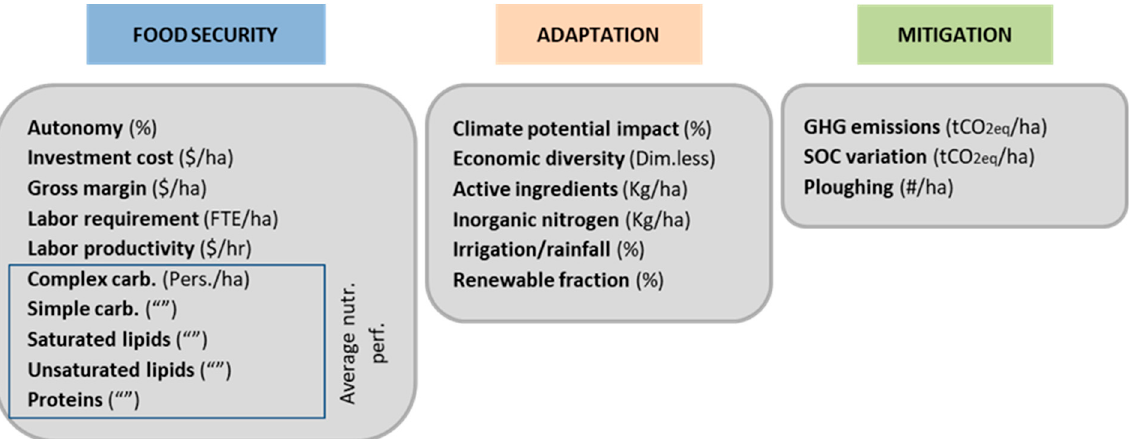
Figure 2. Synthesis of the indicator framework based on the “Triple-win” objectives of food security, adaptation and mitigation.